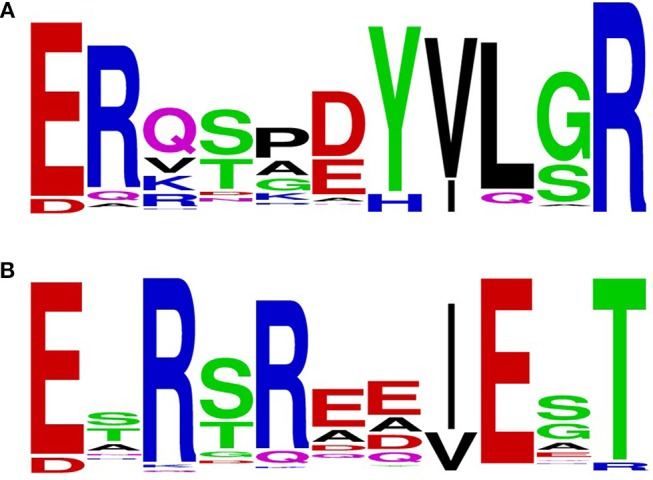
Sequence logos were generated from the aligned sequence parts of PHBHs involved in pyridine nucleotide coenzyme binding using the WebLogo server (ver. 2.8.2, Crooks et al., 2004). (A) Sequence logo generated with the NADPH-specific PHBHPf as BlastP query input; (B) Sequence logo generated with the NADH-preferring PHBHRo as BlastP query input.